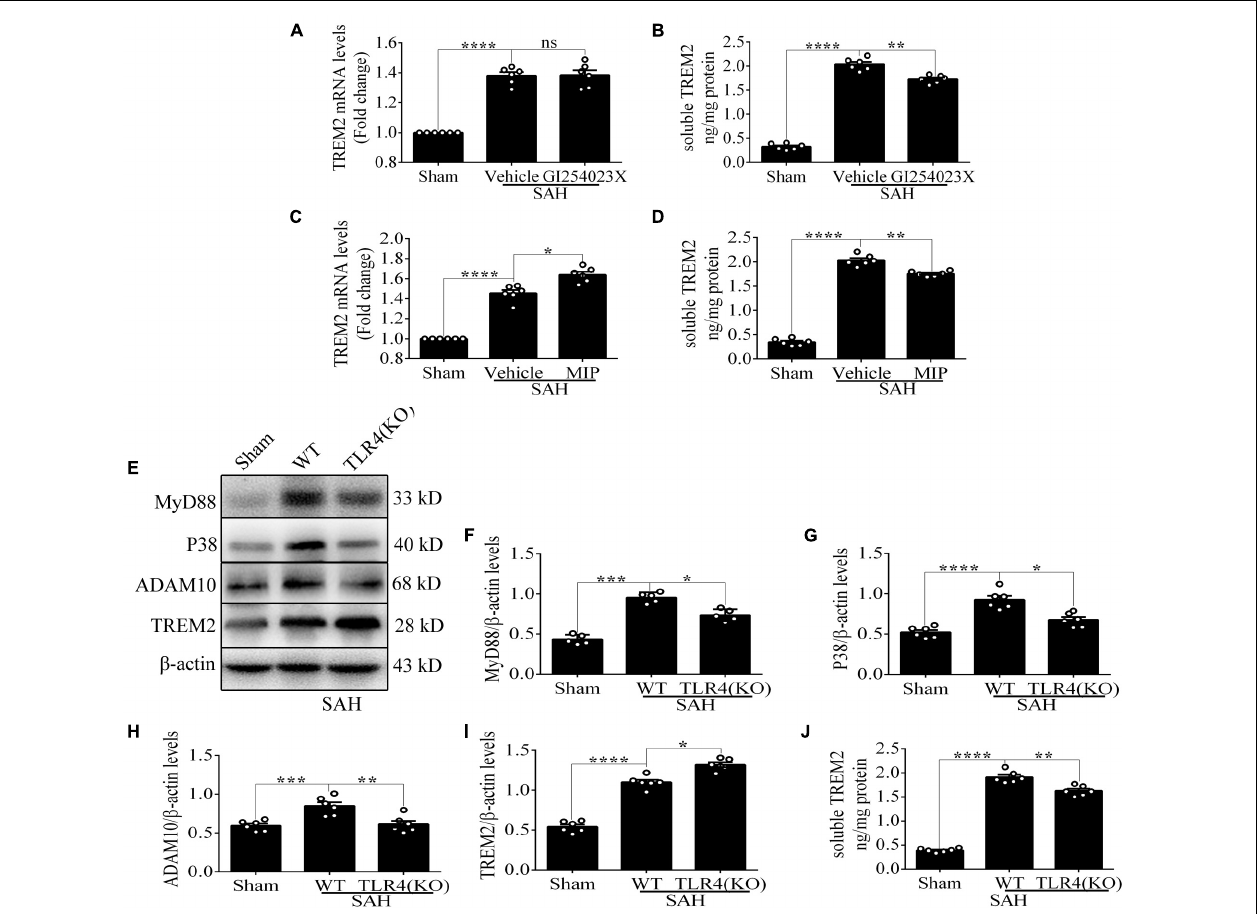
FIGURE 8 | Toll-like receptor 4 ( TLR4 )/MyD88 pathway mediates the expression of triggering receptor expressed on myeloid cells 2 ( TREM2 ) in mouse cortex after subarachnoid hemorrhage (SAH). (A–D) After the treatment with GI254023X or MyD88 inhibitory peptide (MIP) fusion protein, the relative mRNA and soluble levels of TREM2 were detected in order to evaluate the regulatory effect of TLR4 on TREM2 . (E–I) The protein levels of MyD88, P38, ADAM10, TREM2 , and β -actin were quantified by Western blotting. (J) ELISA detection showed the changes of soluble TREM2 . These data are shown as mean ± SEM ( ns p > 0.05, * p < 0.05, ** p < 0.01, *** p < 0.001, **** p <